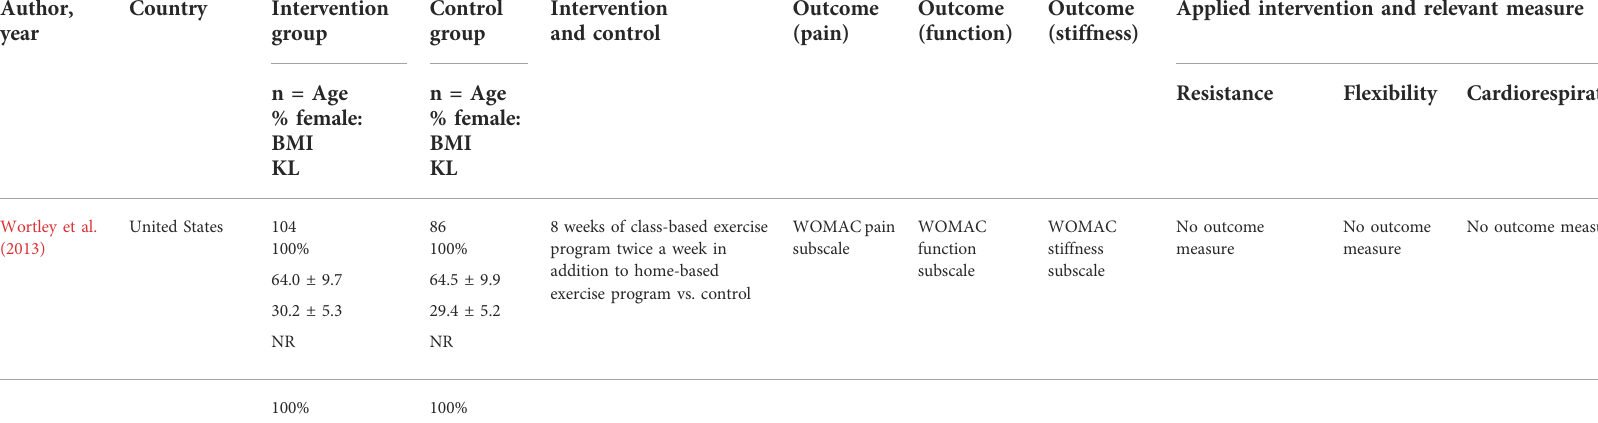
TABLE 4 ( Continued ) Exercise interventions evaluated according to the American College of Sports Medicine ’ s (ACSM) recommendations. Author, Country Intervention Control Intervention year group group and control